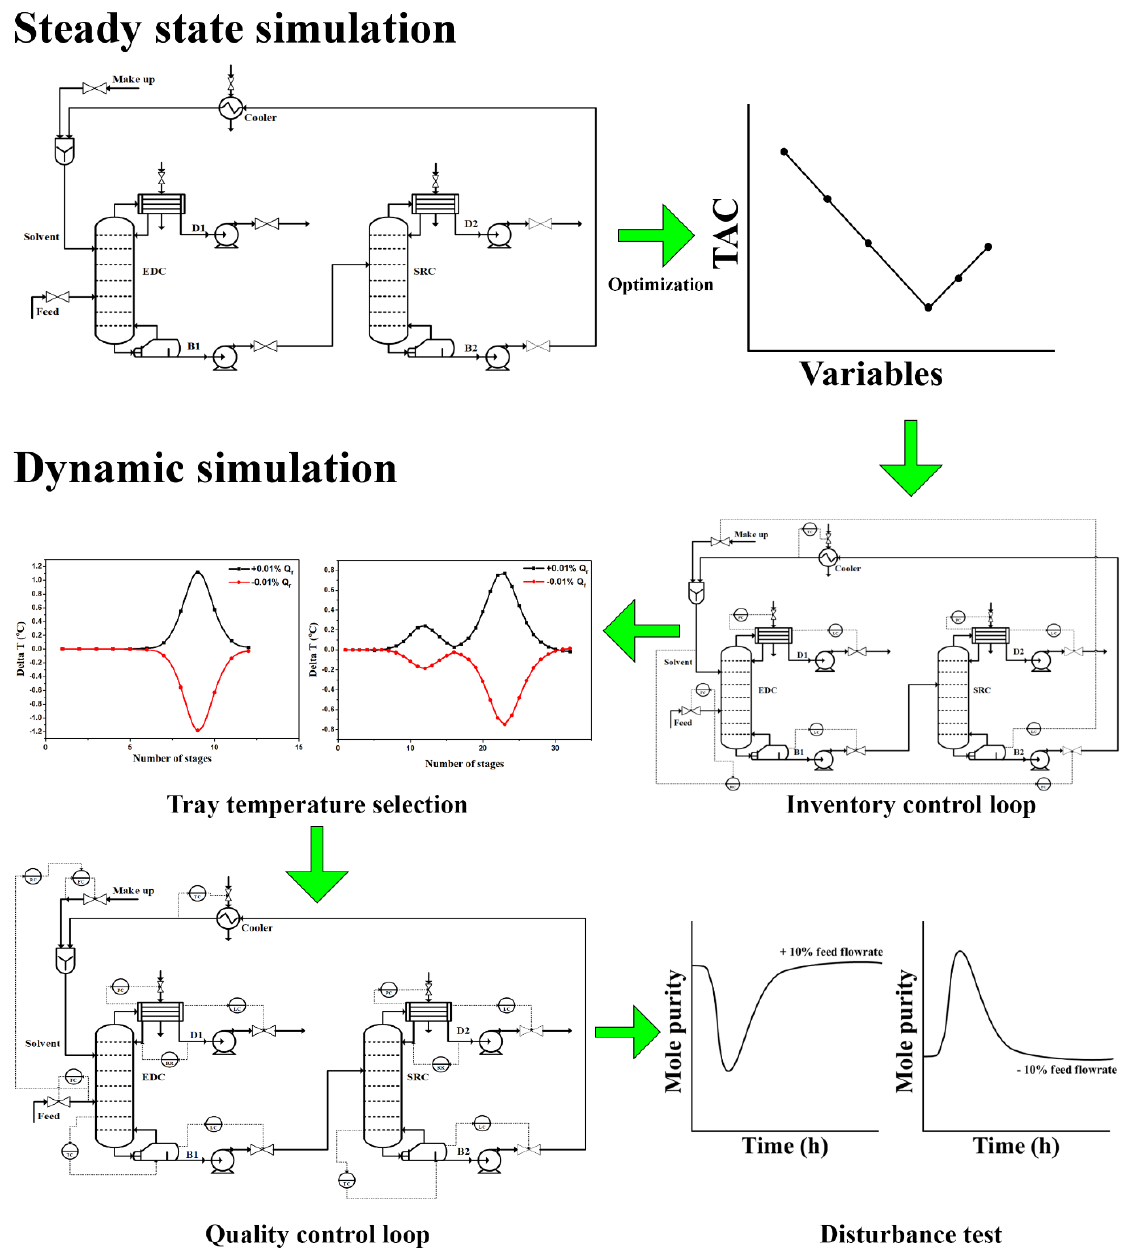
Figure 3. General procedures for evaluating process